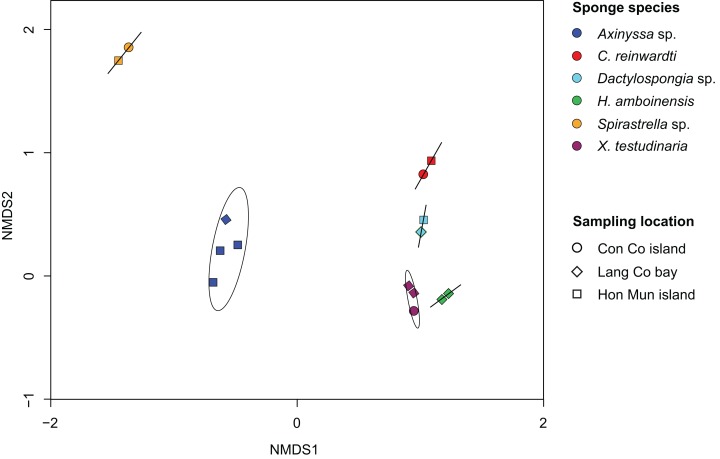
Non-metric multidimensional scaling (NMDS) plot derived from Bray–Curtis distances of sponge prokaryotic communities at OTUs level, NMDS stress value = 0.116.The samples of the same species were grouped with ordination ellipse using function ordiellipse of vegan package.